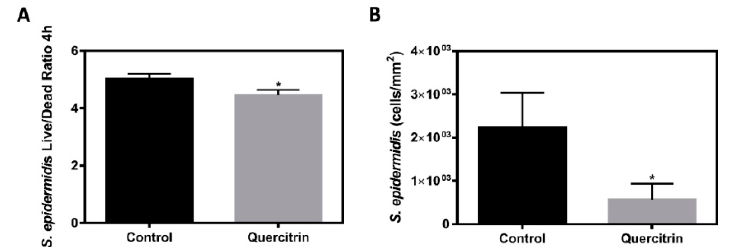
Figure 7. E ff ect of the implants on S. epidermidis survival and adhesion. (A) S. epidermidis Live / Dead Ratio cultured for 4 h on the implants ( n = 6). (B) S. epidermidis adhesion on the implants after 4 h of incubation ( n = 6). Values represent mean (SD). Di ff erences between groups were assessed by Student t -test: * p < 0.05 vs. control.